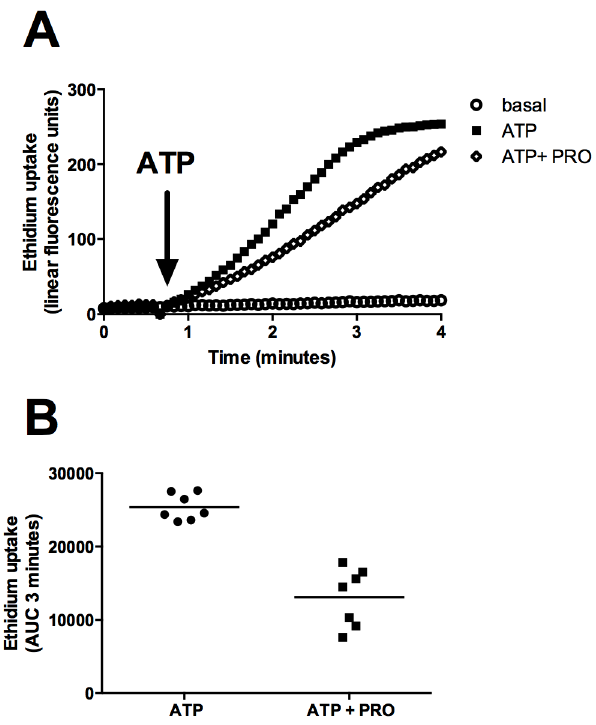
Figure 4. Probenecid inhibits P2X7-induced dye uptake in human CD14 + monocytes. Ethidium + uptake was induced in CD14- APC labelled human monocytes by the addition of 1 mM ATP (denoted by the arrow) in low divalent KCl buffer in the absence and presence of 1 mM probenecid. Dye uptake was measured on a FACSCalibur flow cytometer using a heated time-resolved module. A representative uptake curve is shown from 6 donors (top panel). Data (area under the curve after 3 minutes) from all donors in shown in bottom panel scatter plot.